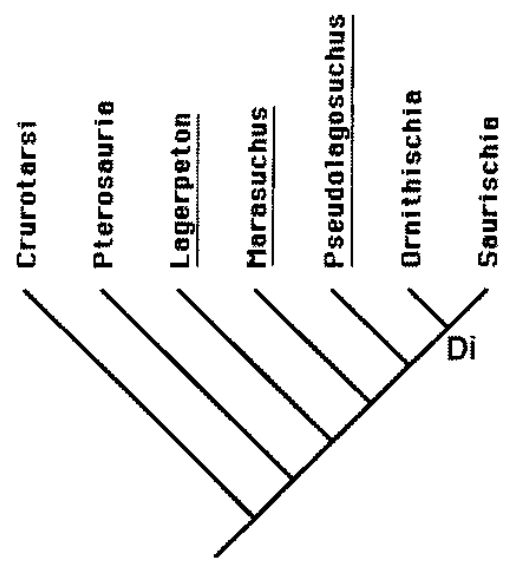
Fig. 7 – Cladogram indicating the relationships of basal or- nithodirans (based on Novas 1996). Abbreviation: Di - Di- nosauria.